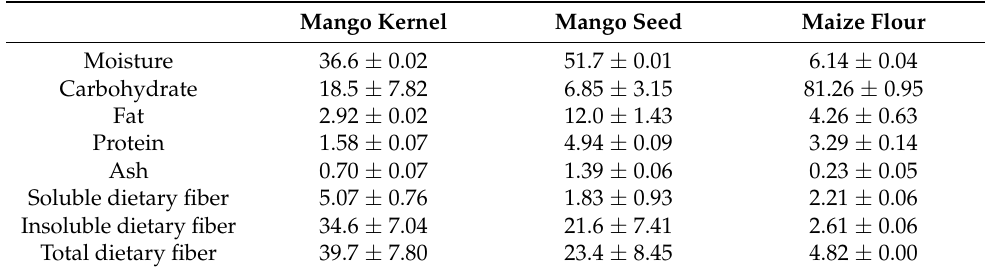
Table 2. Nutrient composition (g/100 g dw) of mango by-products and maize flour. The results are expressed as mean ±